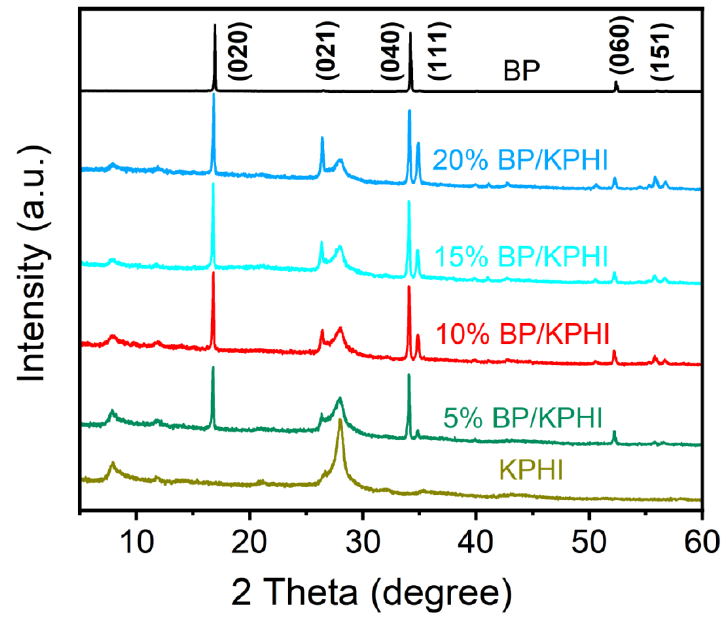
Figure 4. XRD patterns of KPHI, 5%BP/KPHI, 10%BP/KPHI, 15%BP/KPHI, 20%BP/KPHI, and BP.